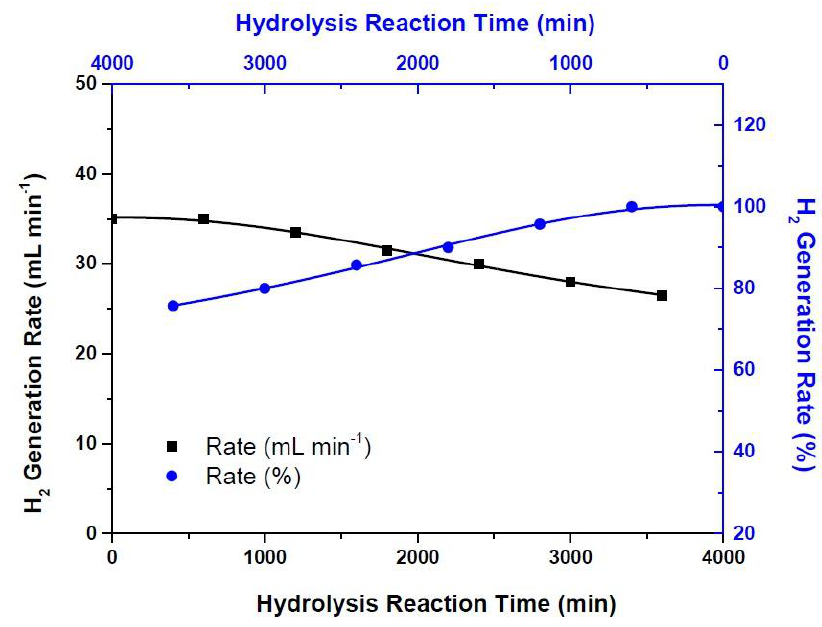
Figure 5. The durability tests of the hydrogen generation catalysts (the percent hydrogen generation rate has been calculated by choosing the highest hydrogen generation rate of 35 mL min −1 as 100%).